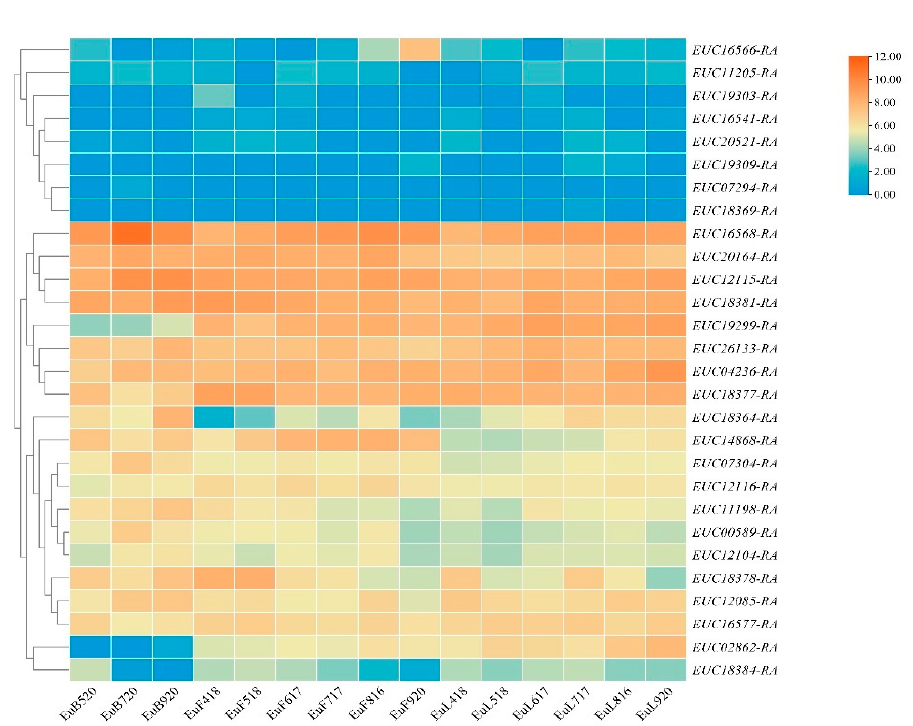
Figure 6. Expression profiles of 28 candidate genes during development of three tissue types. EuL, EuF, and EuB indicate leaf, fruit, and bark, respectively. The following numbers indicate the collection date. The clustering tree was constructed by hierarchical clustering using average linkage method.